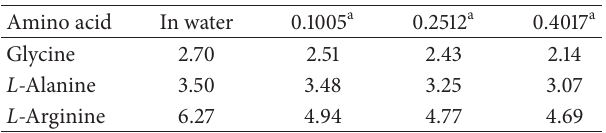
Table 4: hydration number of glycine, L -alaine, and L -arginine in aqueous and aqueous solution of hydroxylamine sulfate at 𝑇 = 298.15